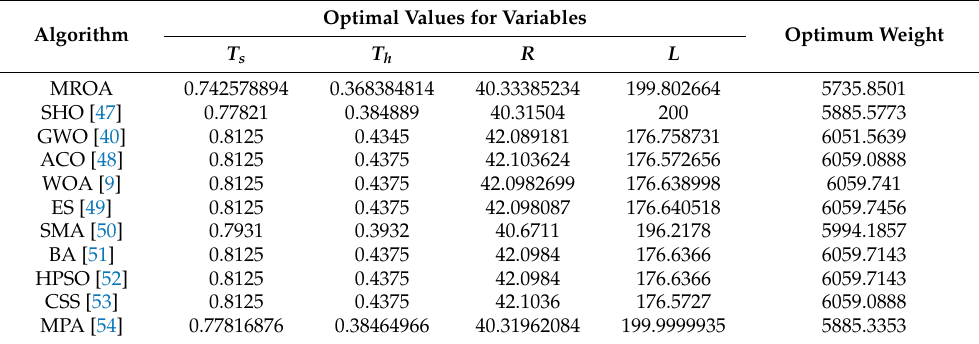
Table 13. Comparison of optimal solutions for the pressure vessel design problem.